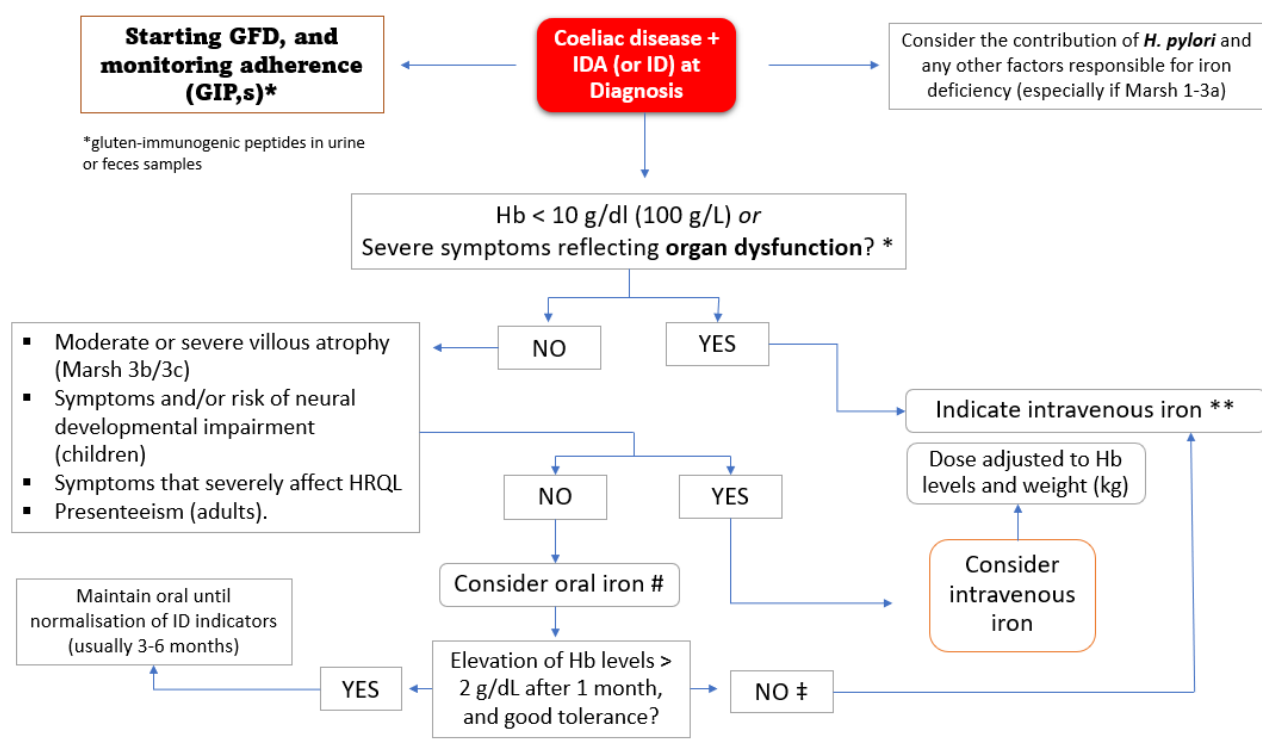
Figure 5. A proposed algorithm for iron replacement in patients with CD and IDA or ID. GFD: gluten-free diet; GIPs: gluten-immunogenic peptides in urine or feces samples; HRQL: health-related quality of life. # In the presence of mild symptoms, consider not giving oral iron and wait for resolution of lesions after GFD. ‡ Some causes of non-response to oral iron replacement include poor adherence to the GFD (consider the presence of GIPs in urine or stool samples as an indicator of poor adherence), slow histological response to the GFD (“slow responders”), refractory celiac, and blood loss due to mucosal lesions (Crohn’s disease, jejunoileitis, and malignancy). (*: Consider transfusion of red blood cells.; ** See Tables 5 and 6).